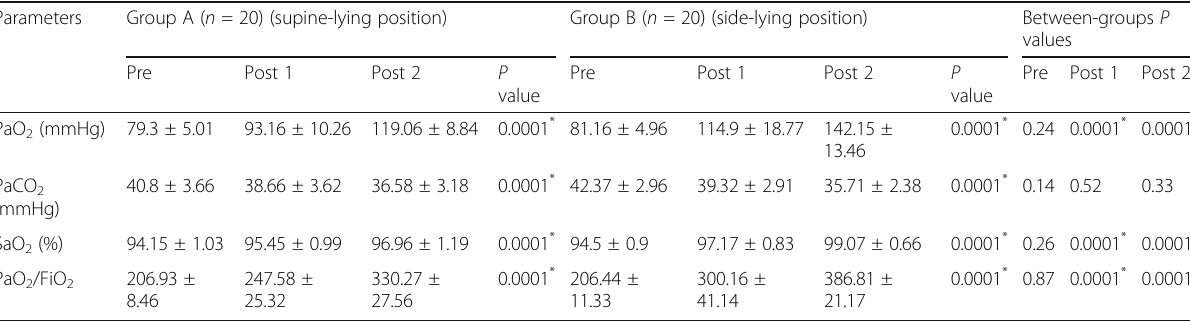
Table 2 Comparison of arterial blood gases between group A and B and between pretreatment, post 1, and post 2 in each group Parameters Group A ( n = 20) (supine-lying position) Group B ( n = 20) (side-lying position) Between-groups P